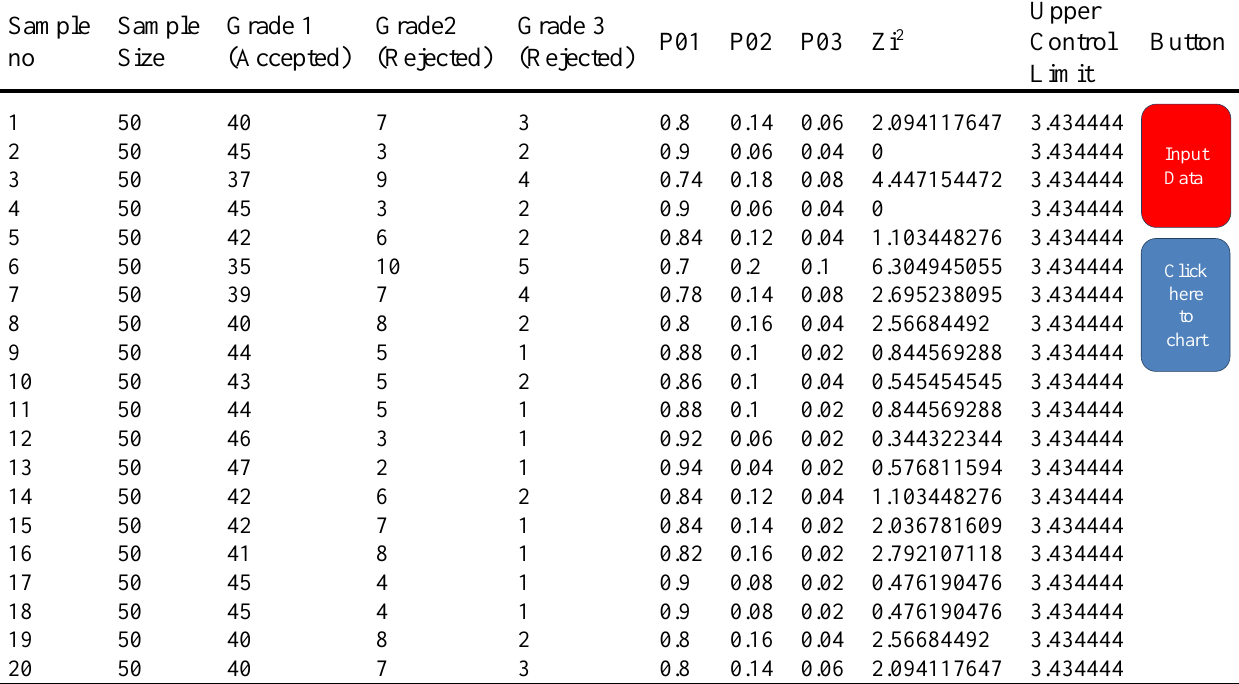
Table 3. Fuzzy P-Control Chart Based on Variable Sample Size TFN